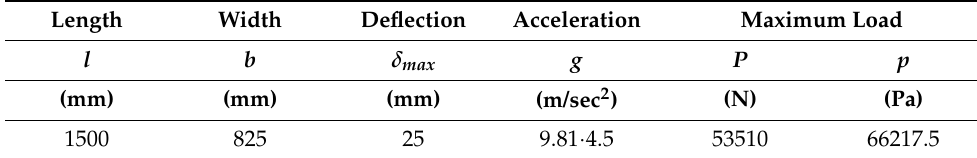
Table 2. Boundary conditions for a simply supported sandwich plate of a helicopter floor.